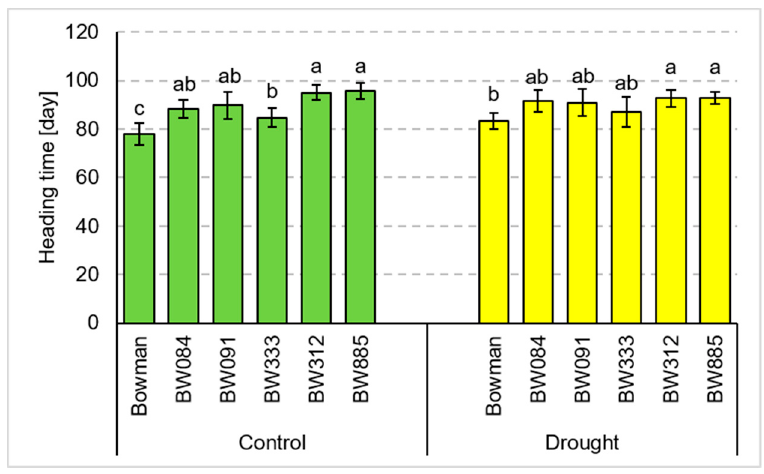
Figure 1. Heading time at which spikes emerged from the leaf sheath under the control and drought conditions. The mean values ± (SD) marked with the same letters (separately for the control and drought-stressed plants) are not significantly different, according to Duncan’s test ( p ≤ 0.05). Details are given in the text.